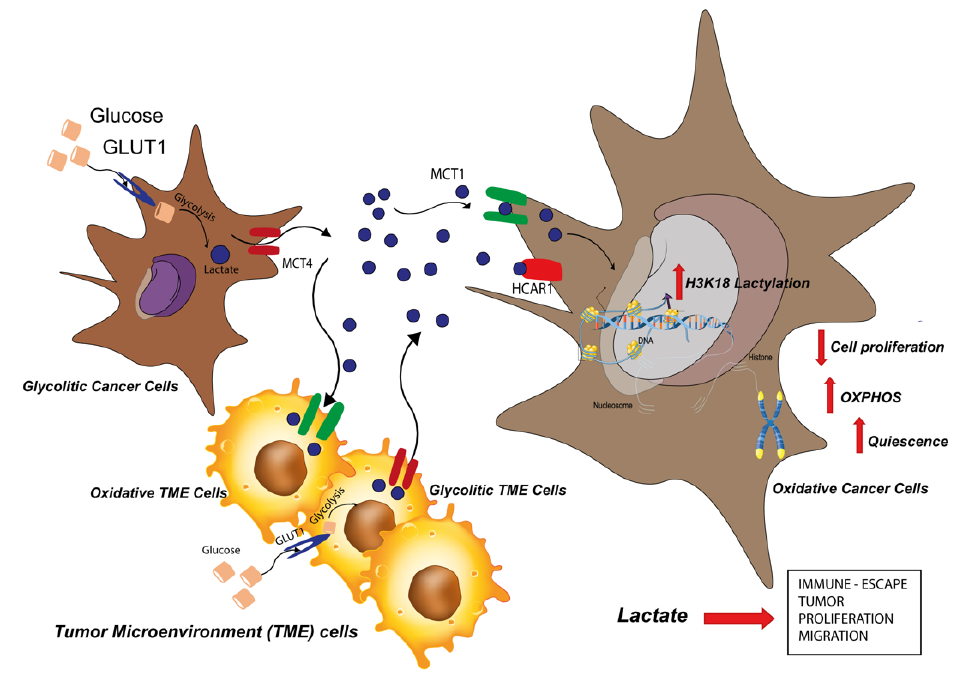
Figure 7. Lactate reshapes the metabolic reprogramming and induces quiescence phenotype in uveal melanoma cells.